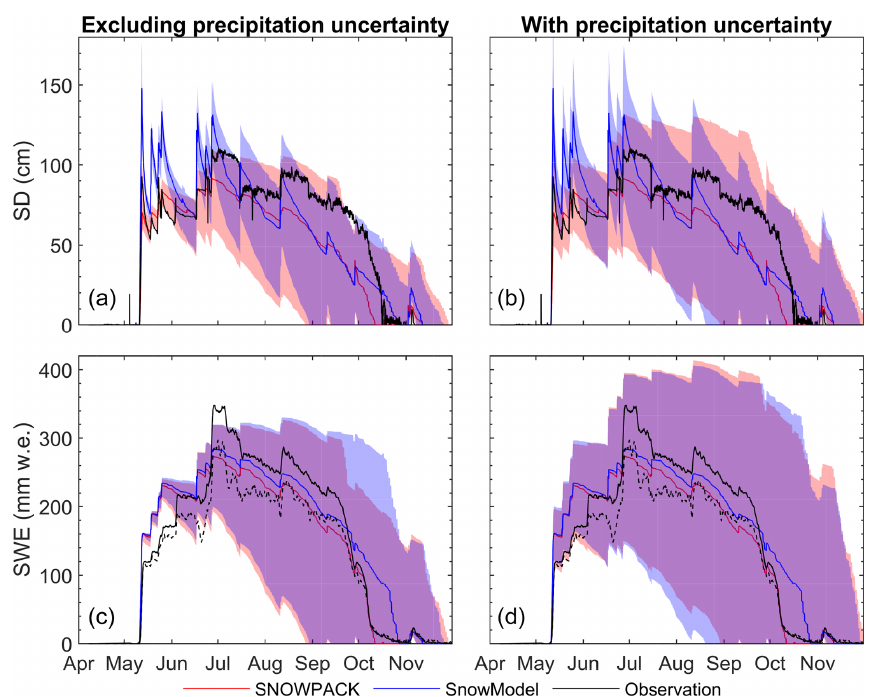
Figure 5. Observed (black) and simulated (colour) SD and SWE by SNOWPACK and SnowModel forced by the 1000 ensembles of meteo- rological data. The reference run (see Sect. 3.2.3) of both models is the bold coloured curve. The shaded area corresponds to the 1000 runs of (a, b) snow depth and SWE (c, d) of SNOWPACK (red) and SnowModel (blue) for the run with biased forcing. Panels (a) – (c) exclude pre- cipitation uncertainties and (b) – (d) include precipitation uncertainties.The solid (dotted) line in (c) and (d) indicates the more (less) reliable SWE measurement from potassium (thallium)